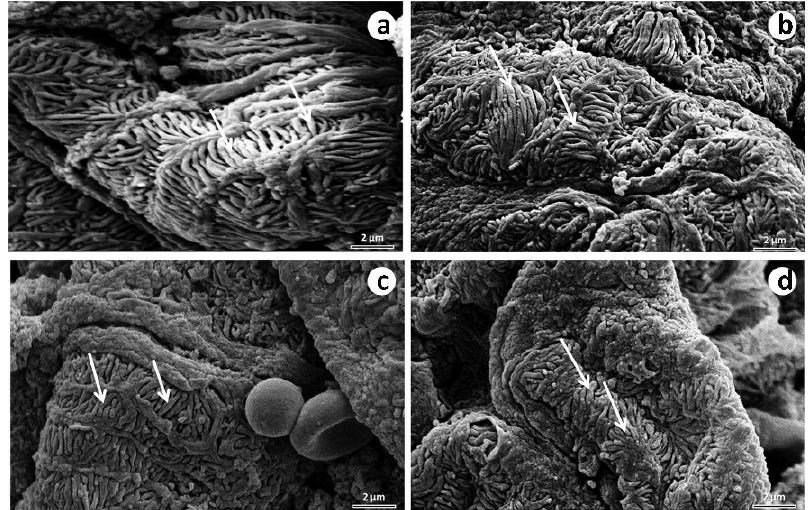
Figure 6 - An electron micrograph of a podocyte foot process. The pedicels (arrow) were more preserved in the SED-WKY (a), EX-WKY (b) and EX-SHR (d) than in the SED-SHR (c), which showed thinner, shorter and more tortuous pedicels. Although the EX-SHR showed pedicel improvement, their morphology was not as well-preserved as in the SED-WKY (a) and EX-WKY (b) control groups. Abbreviations: EX, exercised; SHR, spontaneously hypertensive rats; SED, sedentary; WKY, Wistar-Kyoto